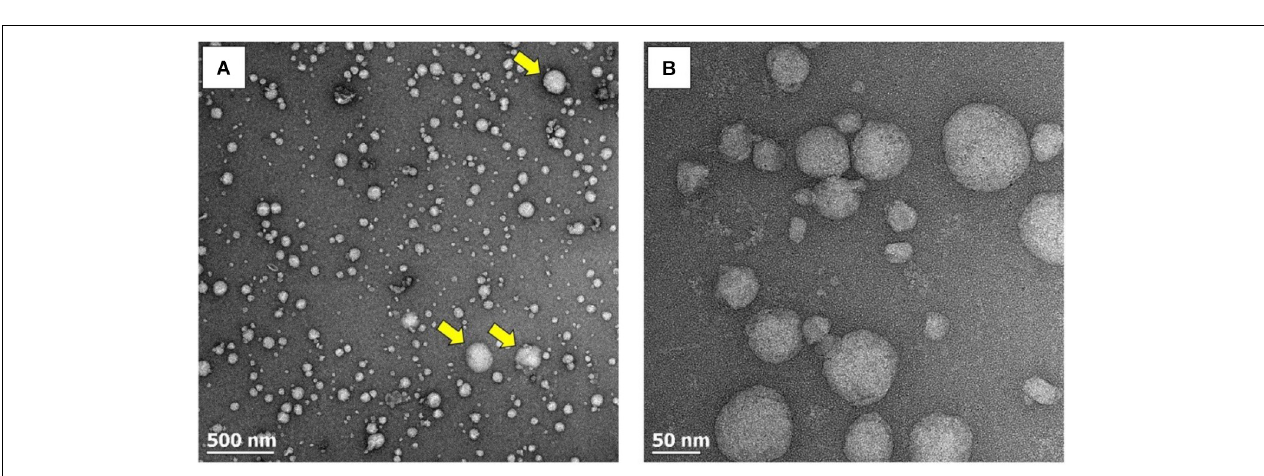
FIGURE 2 | TEM images of EVs at increasing magnifications. (A) A wide-field image revealing the abundance of EVs. EVs within the exosome size range (30–150 nm) predominate, with microvesicles (100–l,000 nm) appearing less frequently (yellow arrows). (B) Highly resolved images of small exosome-sized particles.